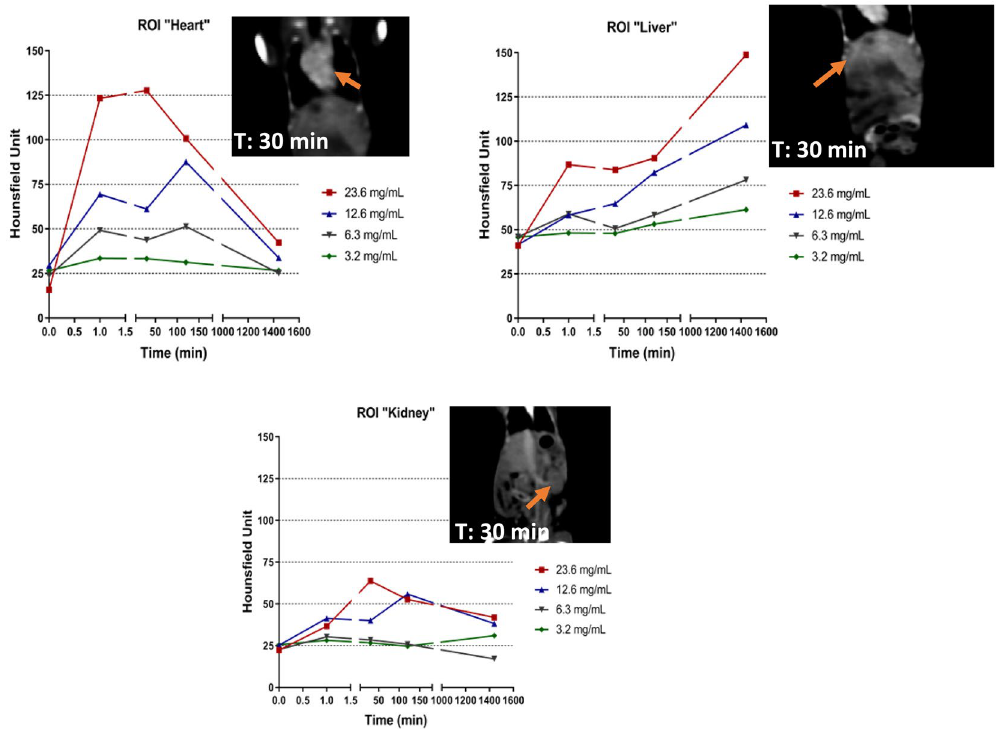
Figure 3. In vivo monitoring and CT images of the hybrid nano-GdF 3 particles in the Heart (top left), the liver (top right), the kidney (bottom). CT images at T = 0 and 1 minute are shown in Fig. 4.